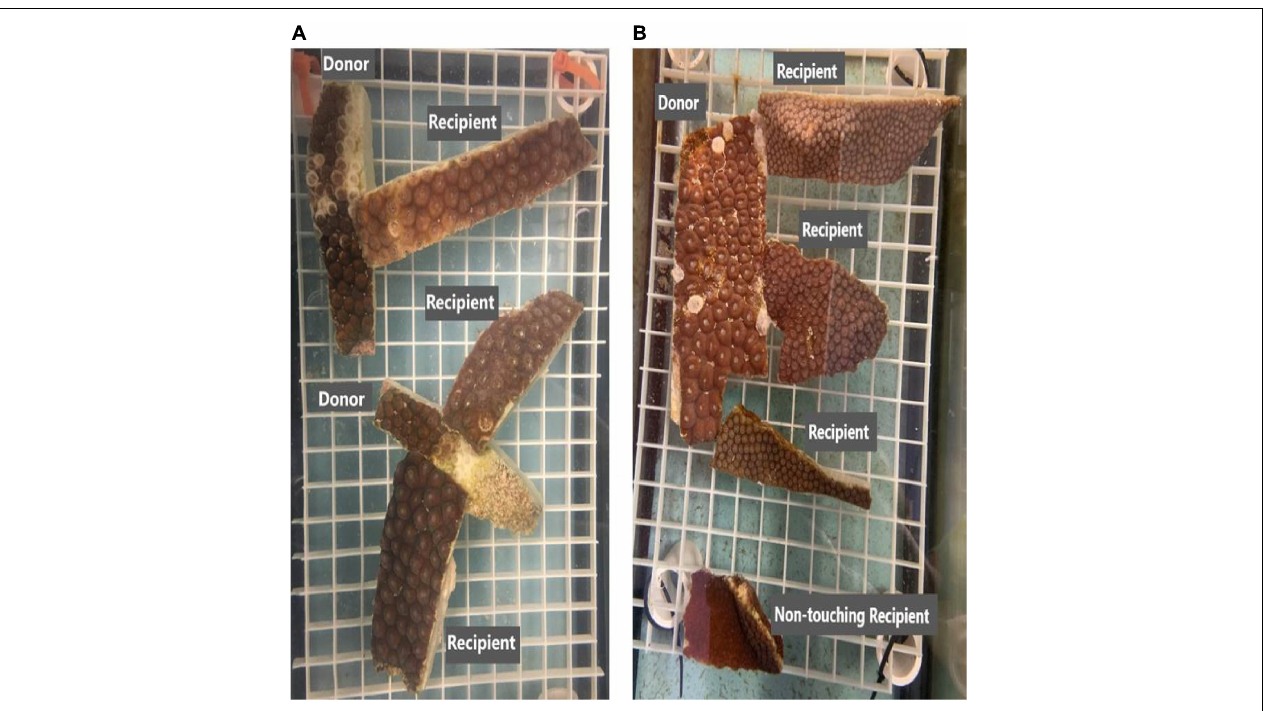
FIGURE 2 | Examples of the experimental set up for the M. cavernosa to M. cavernosa and M. cavernosa to O. faveolata induction experiments, respectively. (A) Aquarium with one M. cavernosa disease donor fragment distance 1 (D1) cut in half, with three touching and one non-touching (NT, not shown) M. cavernosa recipient fragments. (B) Aquarium setup with three O. faveolata recipient fragments touching one M. cavernosa disease donor fragment distance 4 (D4) (exhibiting no grossly visible lesions) and one separate non-touching (NT) O. faveolata recipient